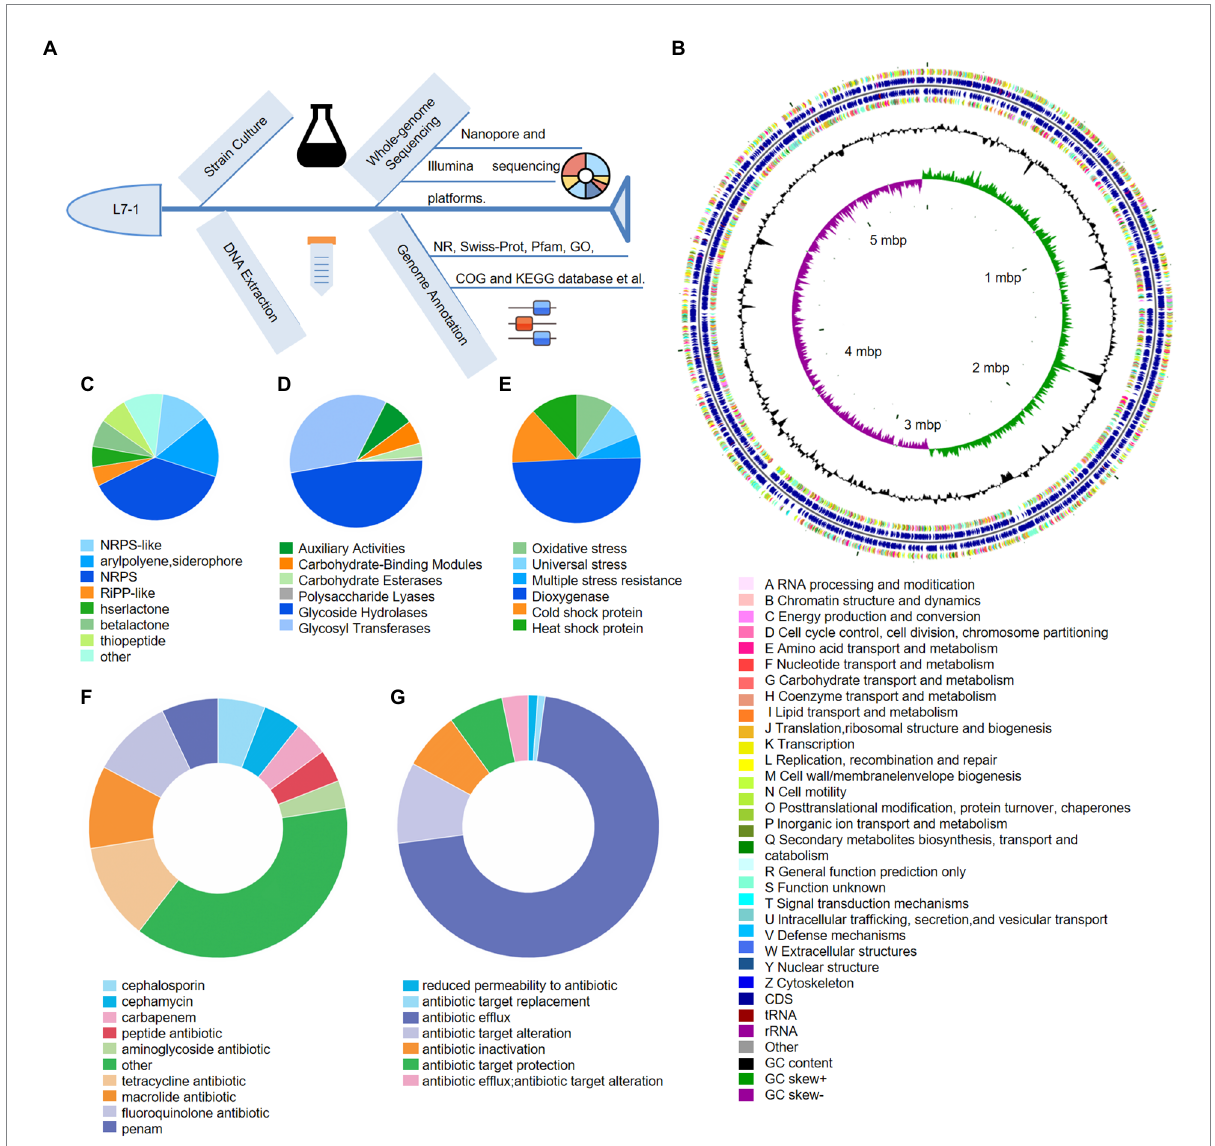
FIGURE 3 Genomic annotation and traits of S. myotis L7-1. (A) Workflow of the whole-genome sequencing of S. myotis L7-1 strain using Nanopore sequencing. (B) Circular map of chromosome of S. myotis L7-1. From outside to inside ring 1 and 4 depicts CDS in the positive strand and negative strand, different colors indicate different COG functional classifications. Ring 2 and 3 depicts CDS, tRNA and rRNA in the positive strand and negative strand. Ring 5 and 6 represents GC content and GC skew, respectively. cloud.majorbio.com. (C) Composition and relative abundance of secondary metabolic synthesis gene cluster genes of S. myotis L7-1. (D) Composition and relative abundance of CAZyme genes of S. myotis L7-1. (E) Composition and relative abundance of environmental adaptation genes of S. myotis L7-1. (F) Composition and relative abundance of antibiotic resistance genes of S. myotis L7-1. (G) Composition and relative abundance of antibiotic resistance mechanism of S. myotis L7-1. Origin